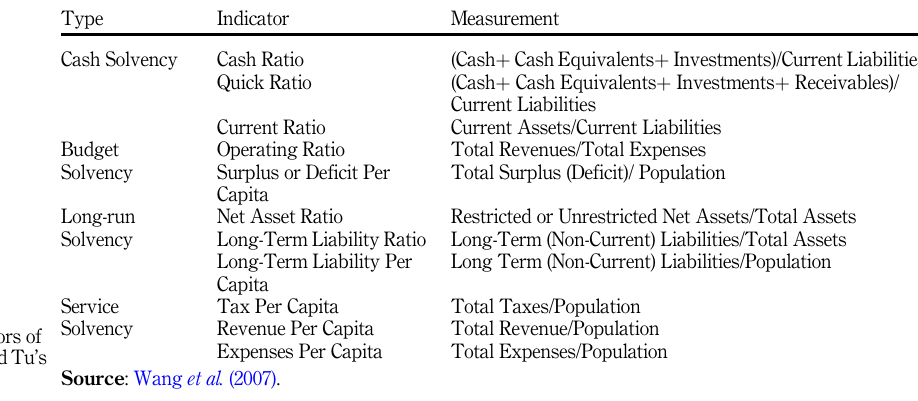
Table 2. Financial indicators of Wang,DennisandTu ’ s solvency